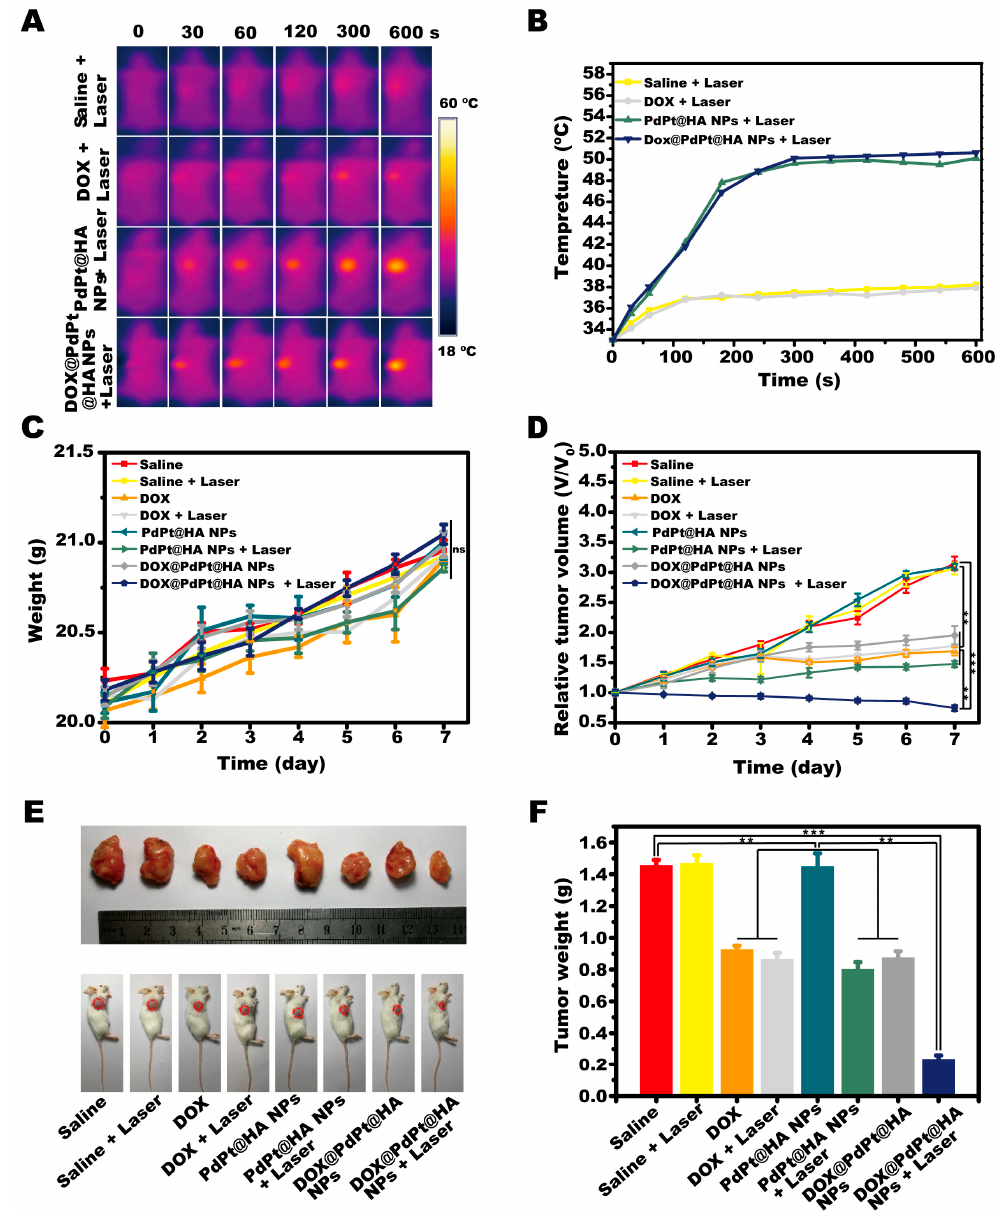
Figure 4. DOX@PdPt@HA NPs for in vivo combination therapy. ( A ) Thermal images of 4T1 tumor-bearing mice recorded by infrared thermal imaging camera. ( B ) Temperature changes of 4T1 tumors in di ff erent groups during laser irradiation. ( C , D ) Body weight of mice and growth of 4T1 tumors were monitored during the in vivo study. ( E ) Representative photographs of mice and excised tumors at the end of study. ( F ) Weight of tumor collected from animals in di ff erent groups. ns, no significant di ff erence. Values represent mean ± SE ( n = 6 in each group). P values: ** P < 0.05, ** P < 0.01, *** P < 0.001.